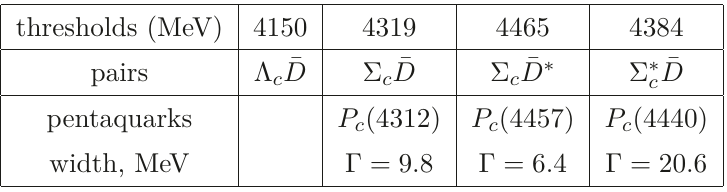
Table 1 . Meson-baryon thresholds and the associated